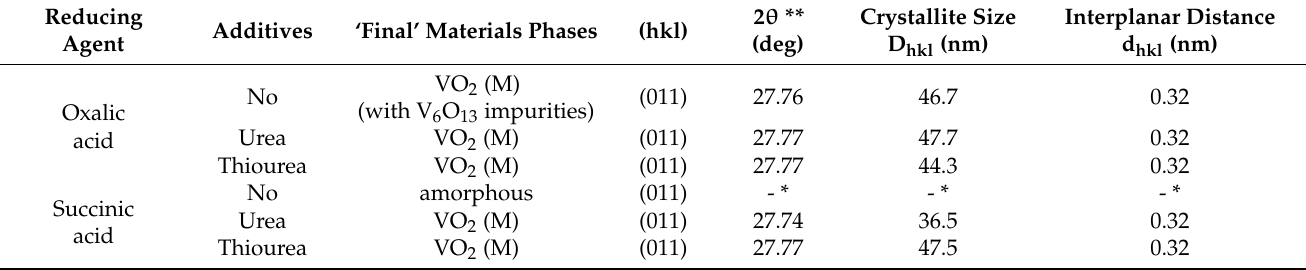
Table 2. Calculated crystallite size and interplanar distance of the ‘final’